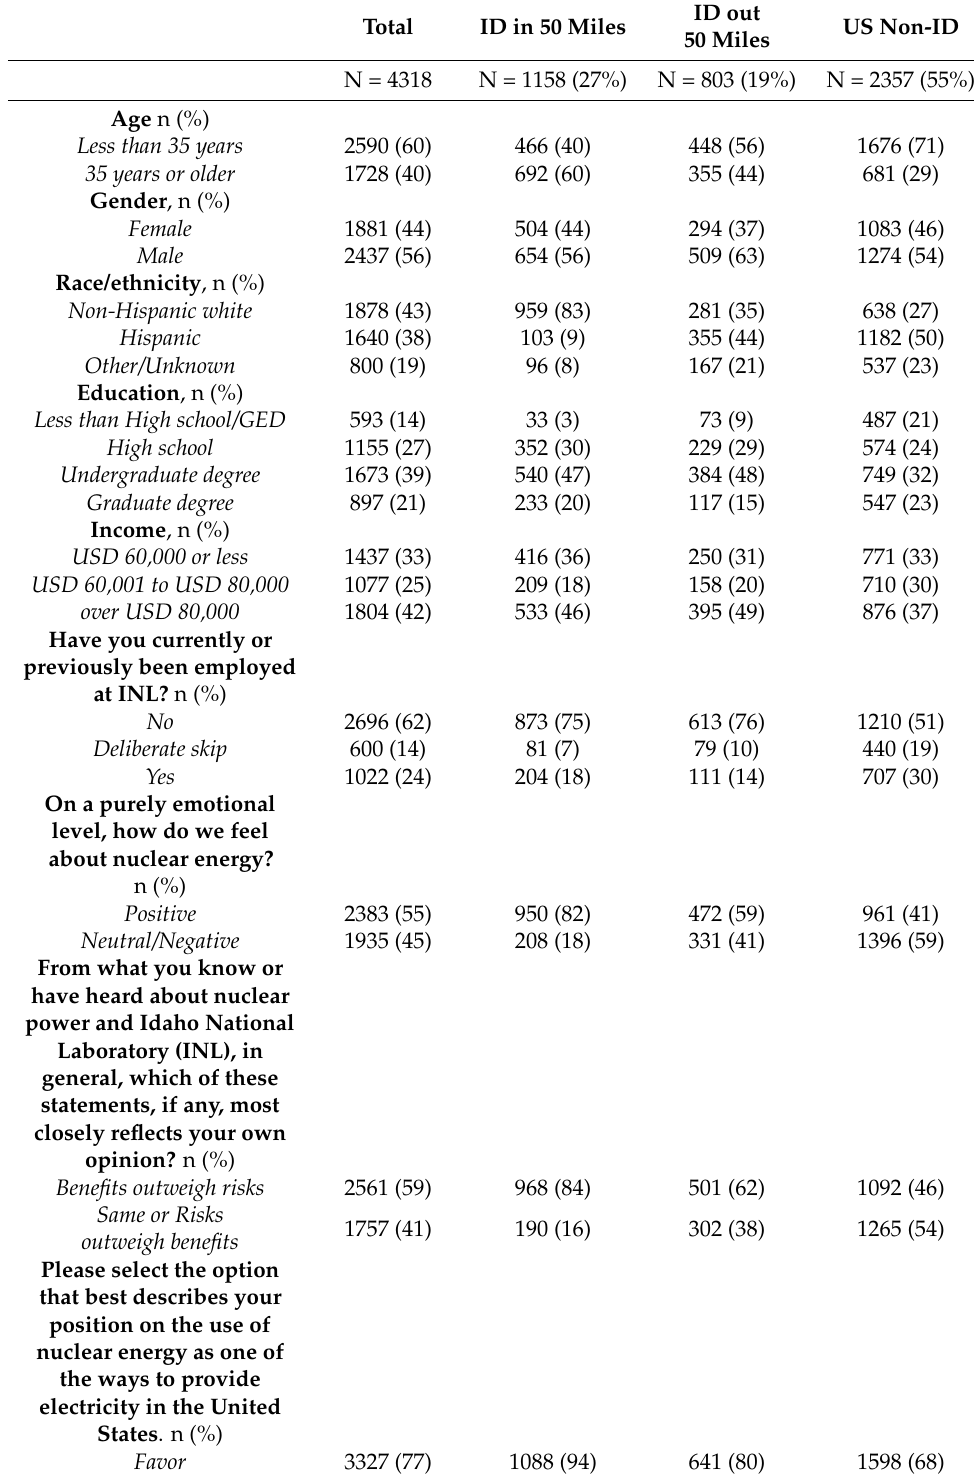
Table 1. Socio-demographic characteristics and perceptions towards nuclear energy of the study participants (N =